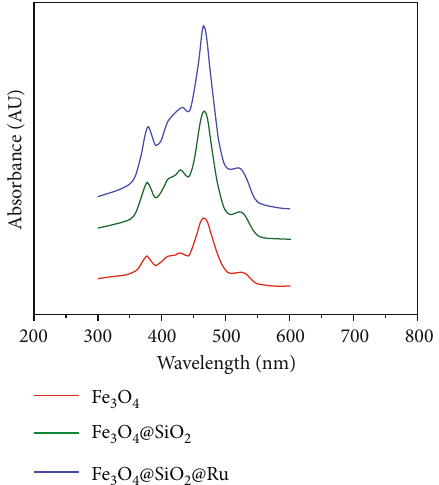
Figure 8: PL spectra of Fe Fe O @SiO @Ru HMCs. 3 4 2